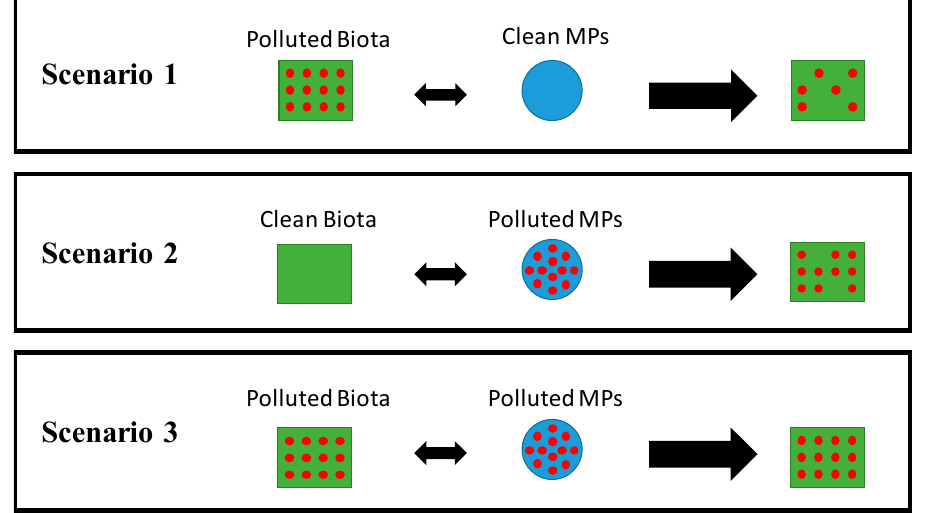
Figure 5. Schematic representation of the three possible bioaccumulation scenarios to assess the role of MPs (blue circles) as vectors of environmental pollutants (red dots) in marine biota (green squares).